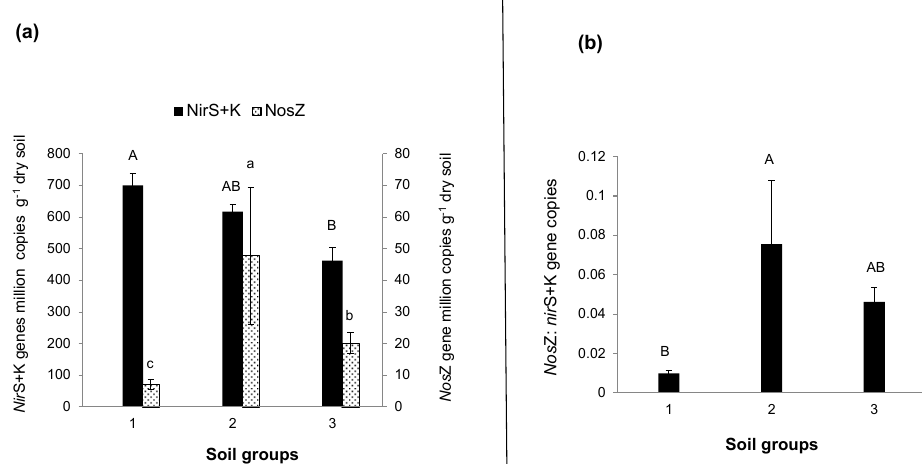
Figure 4. (a) Denitrifier gene ( nir S, nir K, nos Z) copy numbers in different soil groups; error bars denote SEM. (b) Denitrifier gene abundance ratio ( nos Z: nir S, nir K) in different soil groups. Mean values are reported ± 1SE of the mean. Columns with the same letters are not significantly different. Letter values with same case or font denote one test (one test for each of the